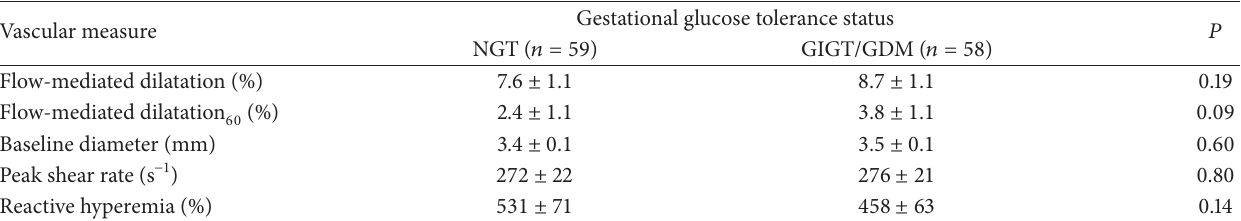
Table 2: Mean adjusted levels of vascular measures from gestational glucose tolerance group after adjustment for age, years since delivery, ethnicity, current BMI, mean supine DBP, current glucose intolerance, smoking history, and menstrual